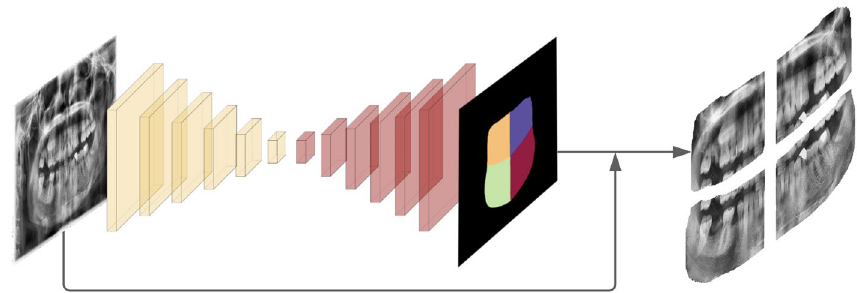
Figure 1. Quadrant segmentation model; a panoramic X-ray image is fed into the quadrant segmentation model to be segmented into 4 quadrants. Then, each quadrant is cropped with a